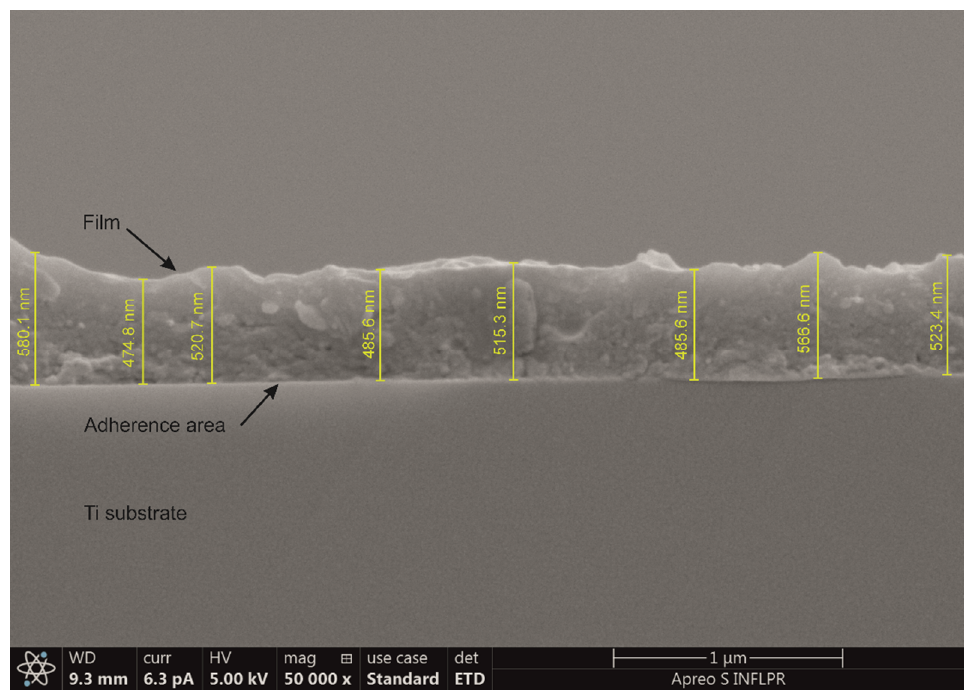
Figure 2. Typical cross-section SEM image of as-deposited composite coating.